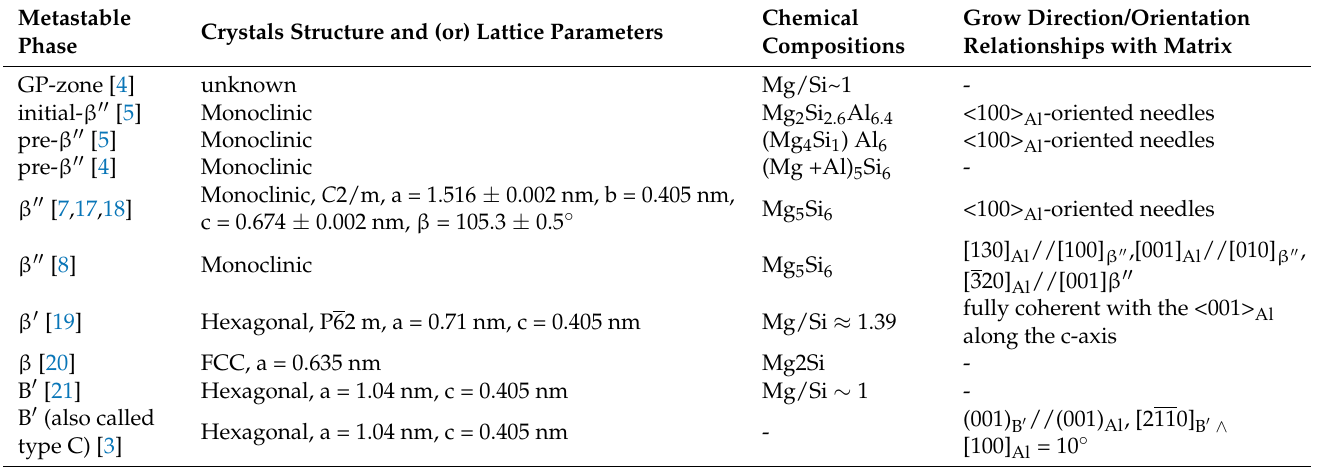
Table 1. Overview of the crystal structures of metastable phases in the Al-Mg-Si